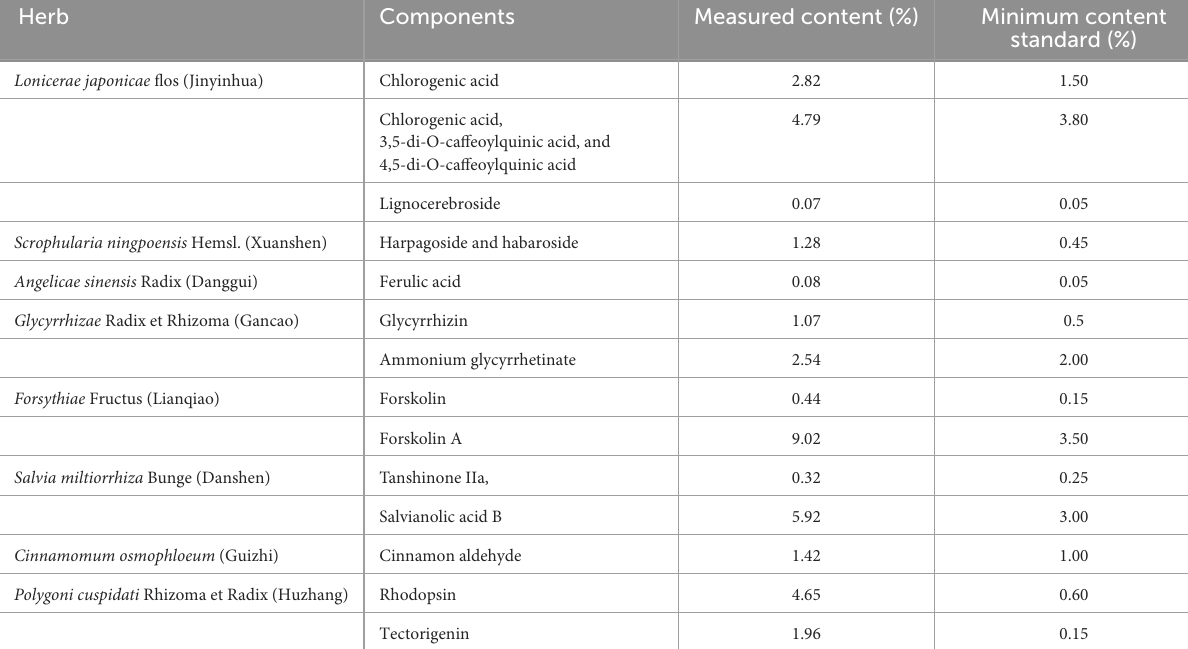
TABLE 1 Determination of major components in different herbs ( n = 3).